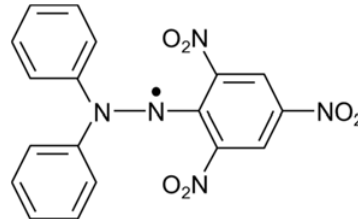
Figure 1. Chemical structure of 2,2-diphenyl-1-(2,4,6-trinitrophenyl)hydrazyl (DPPH) free radical.